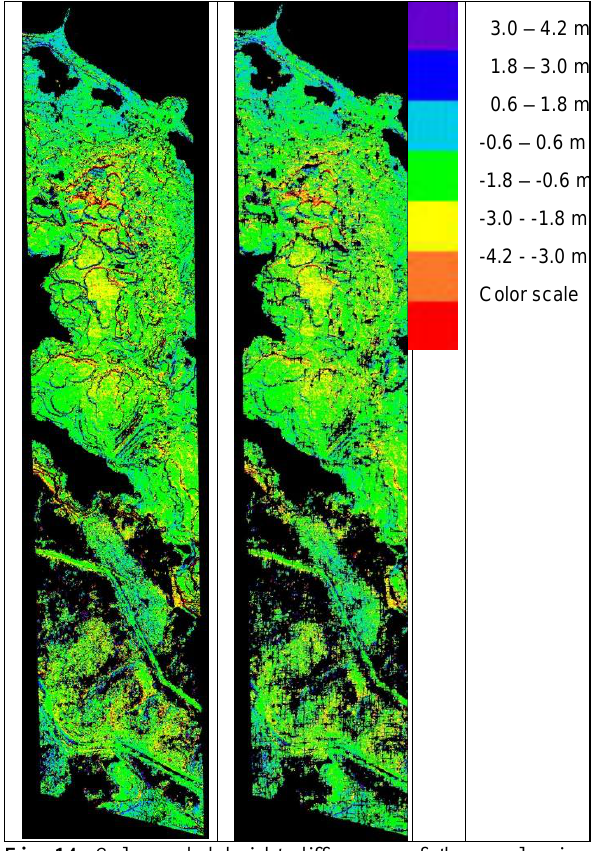
Fig. 14 : Color coded height differences of the overlapping height models – left original, right after filtering The size of the height discrepancies between the overlapping height models is not equal distributed (figure 14); it is depending upon the terrain slope and the contrast in the different parts.